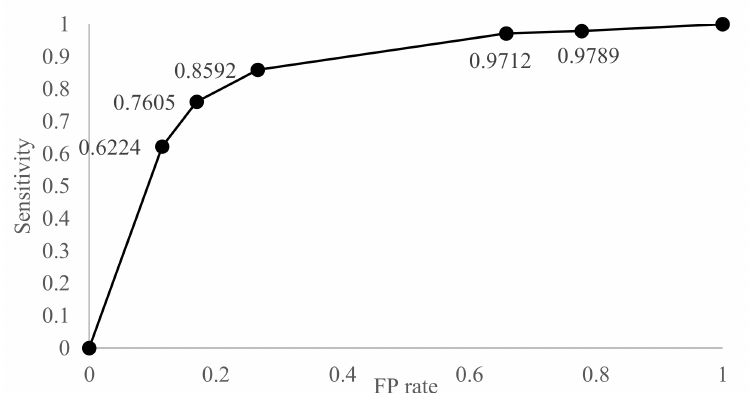
Figure 5. ROC curve for the proposed BN.